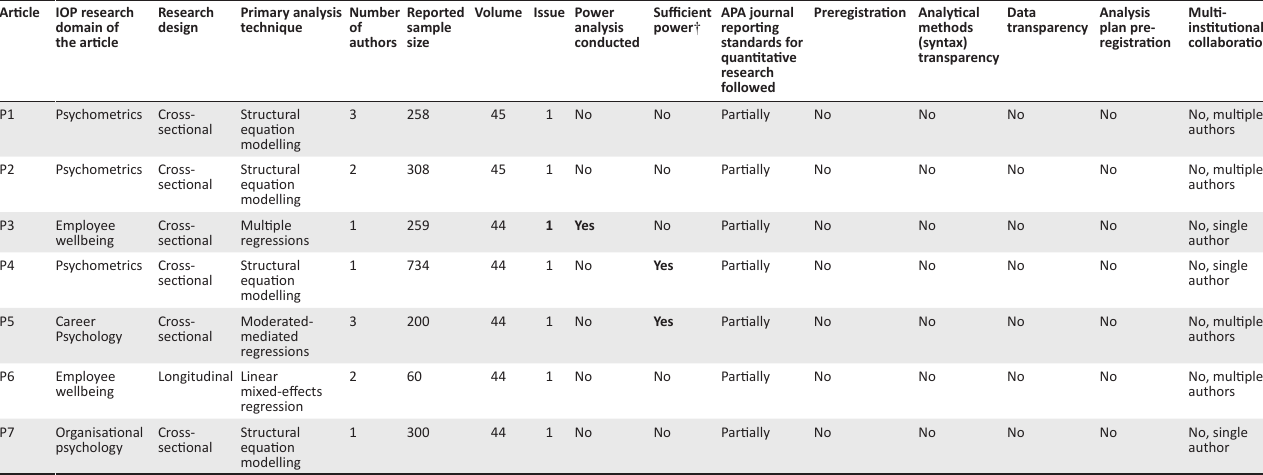
TABLE 1: Descriptive overview of seven randomly selected quantitative papers from SAJIP volumes 44 and